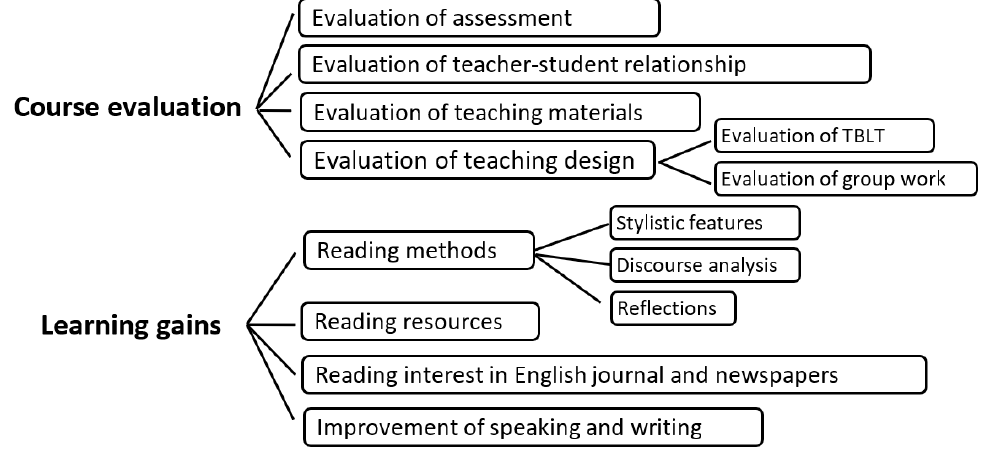
Fig. 2 Data analysis and